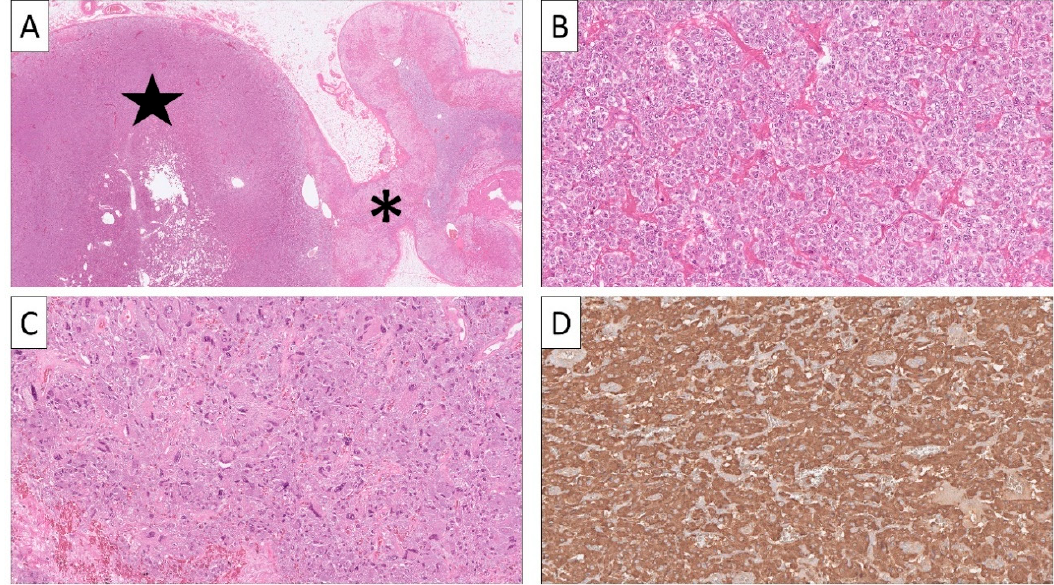
Figure 3. All images represent staining with hematoxylin-eosin (H&E) unless otherwise specified. A . Low-power image of a pheochromocytoma (star) arising in adrenal gland asterisk). B . High-power view illustrating the classical nested appearance of the tumor cells with a finely granular, amphophilic cytoplasm. C. Subsets of cases may display nuclear pleomorphism and hyperchromatic nuclei. D . Immunohistochemistry reveals diffuse chromogranin A positivity.